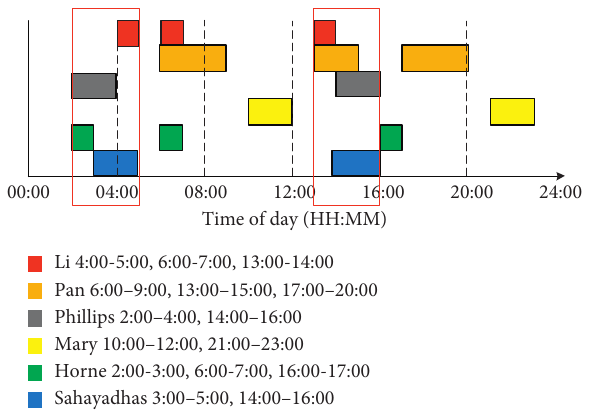
Figure 2: Fatigue peak period of the circadian